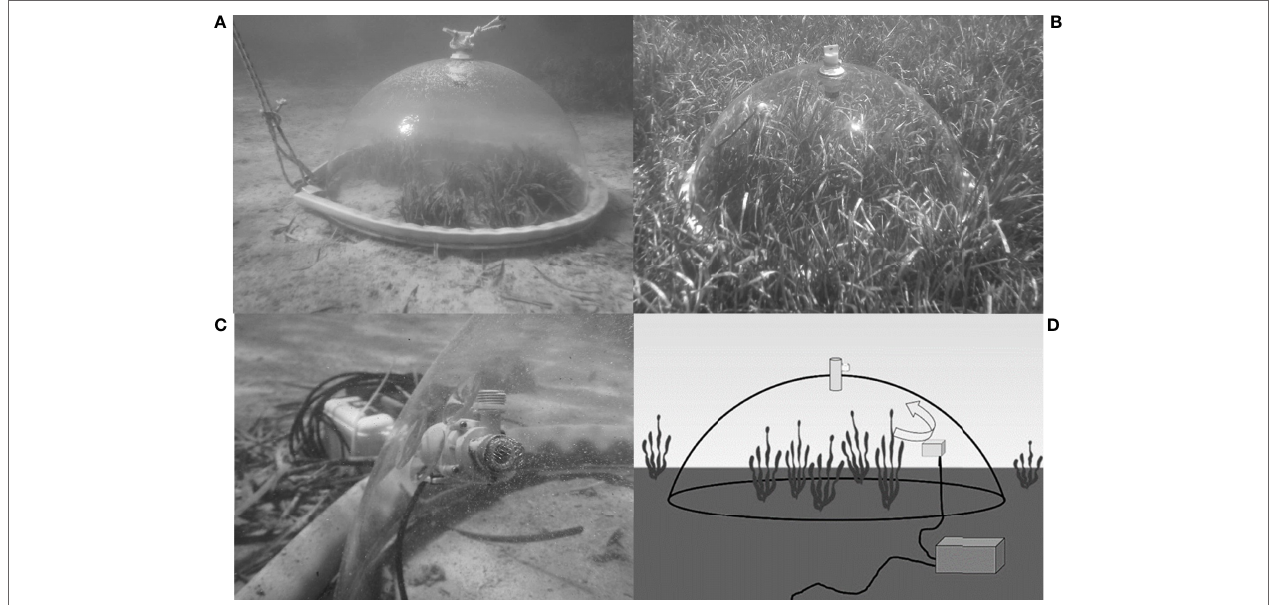
FIGURE 1 | Large benthic chamber setup (A) Deployed in autumn over P. oceanica edge habitat (B) Deployed in summer over dense central P. oceanica meadow. (C) Setup of the internal water pump (foreground) within bare sand incubation. External submersible pump battery pack in background. (D) Illustration of large benthic chamber set-up. Photographs © Emma A Ward, Illustration © Tom